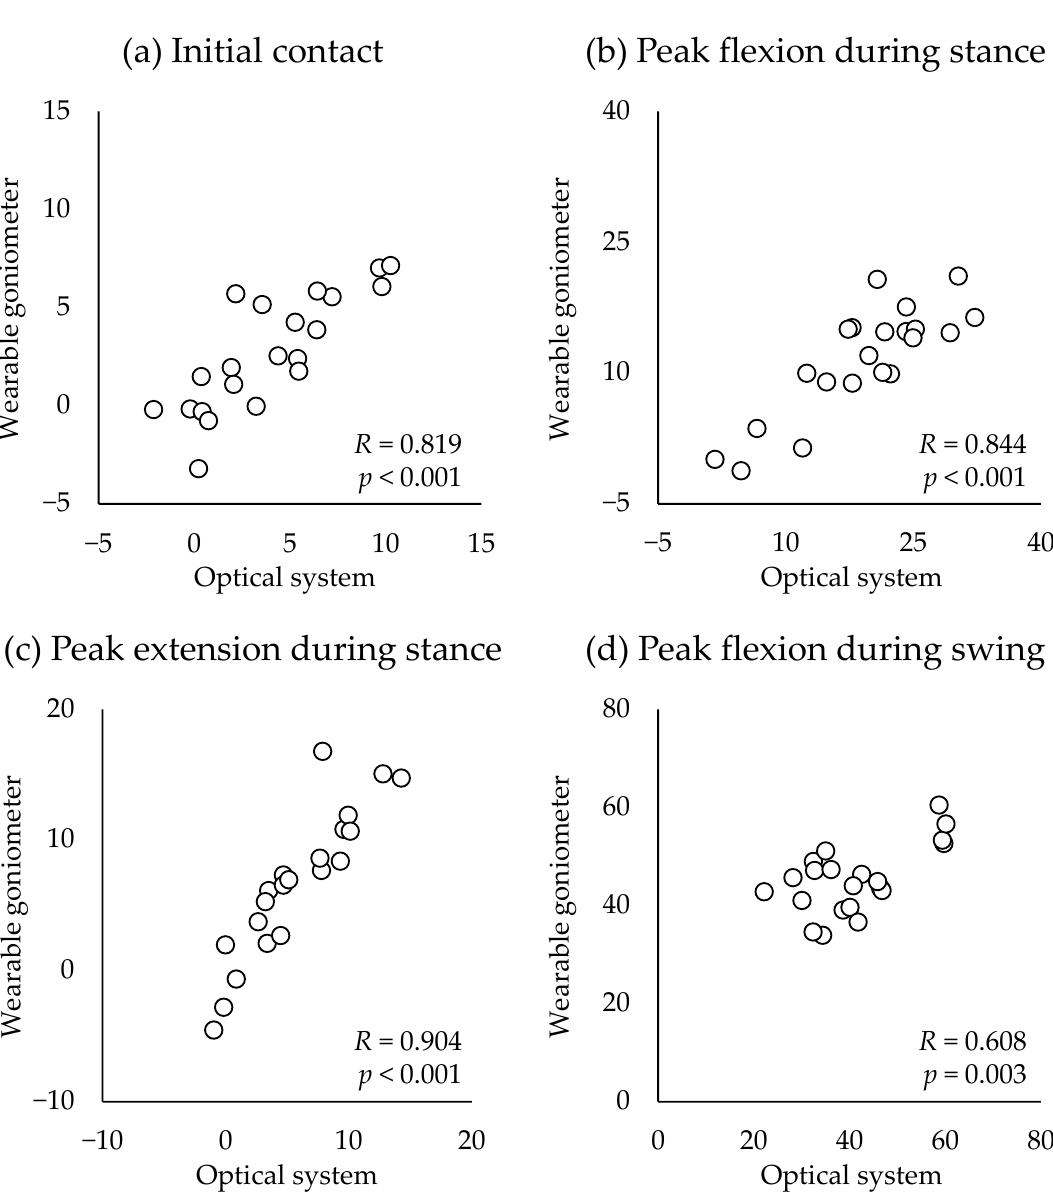
Figure 6. Correlations of the discrete values between optical motion analysis system and wearable